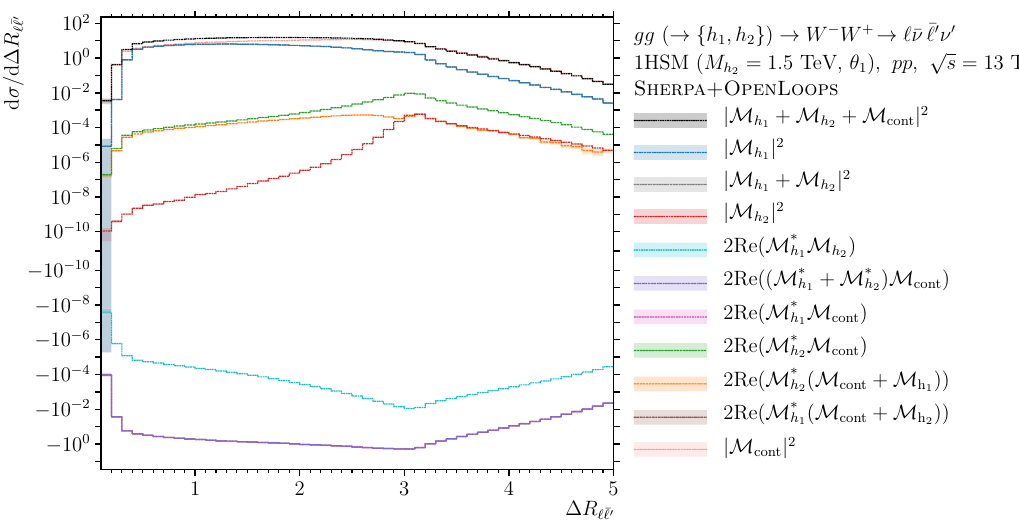
Figure 9 . ∆ R distributions for the signal process gg ( (cid:31) ¯ (cid:31) (cid:31) = 1500 GeV, θ 1 ) including its interference with the background in pp collisions at the 1HSM ( M h 2 √ s = 13 TeV. Other details as in figure